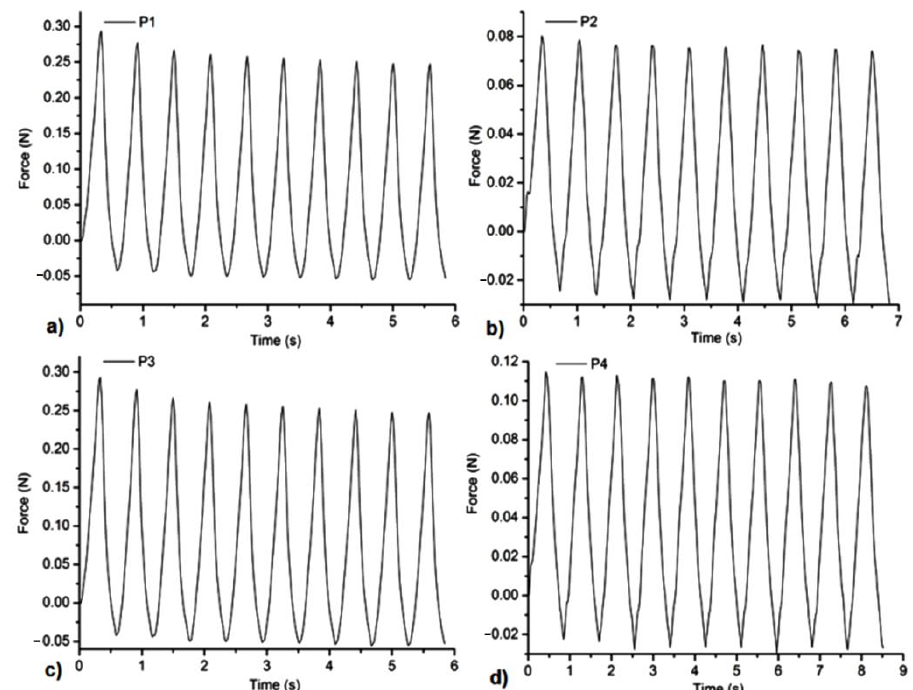
Figure 7. Compression tests of the samples at 20% compressive strains: a ) — P1, b ) — P2, c ) — P3, and d ) — P4.